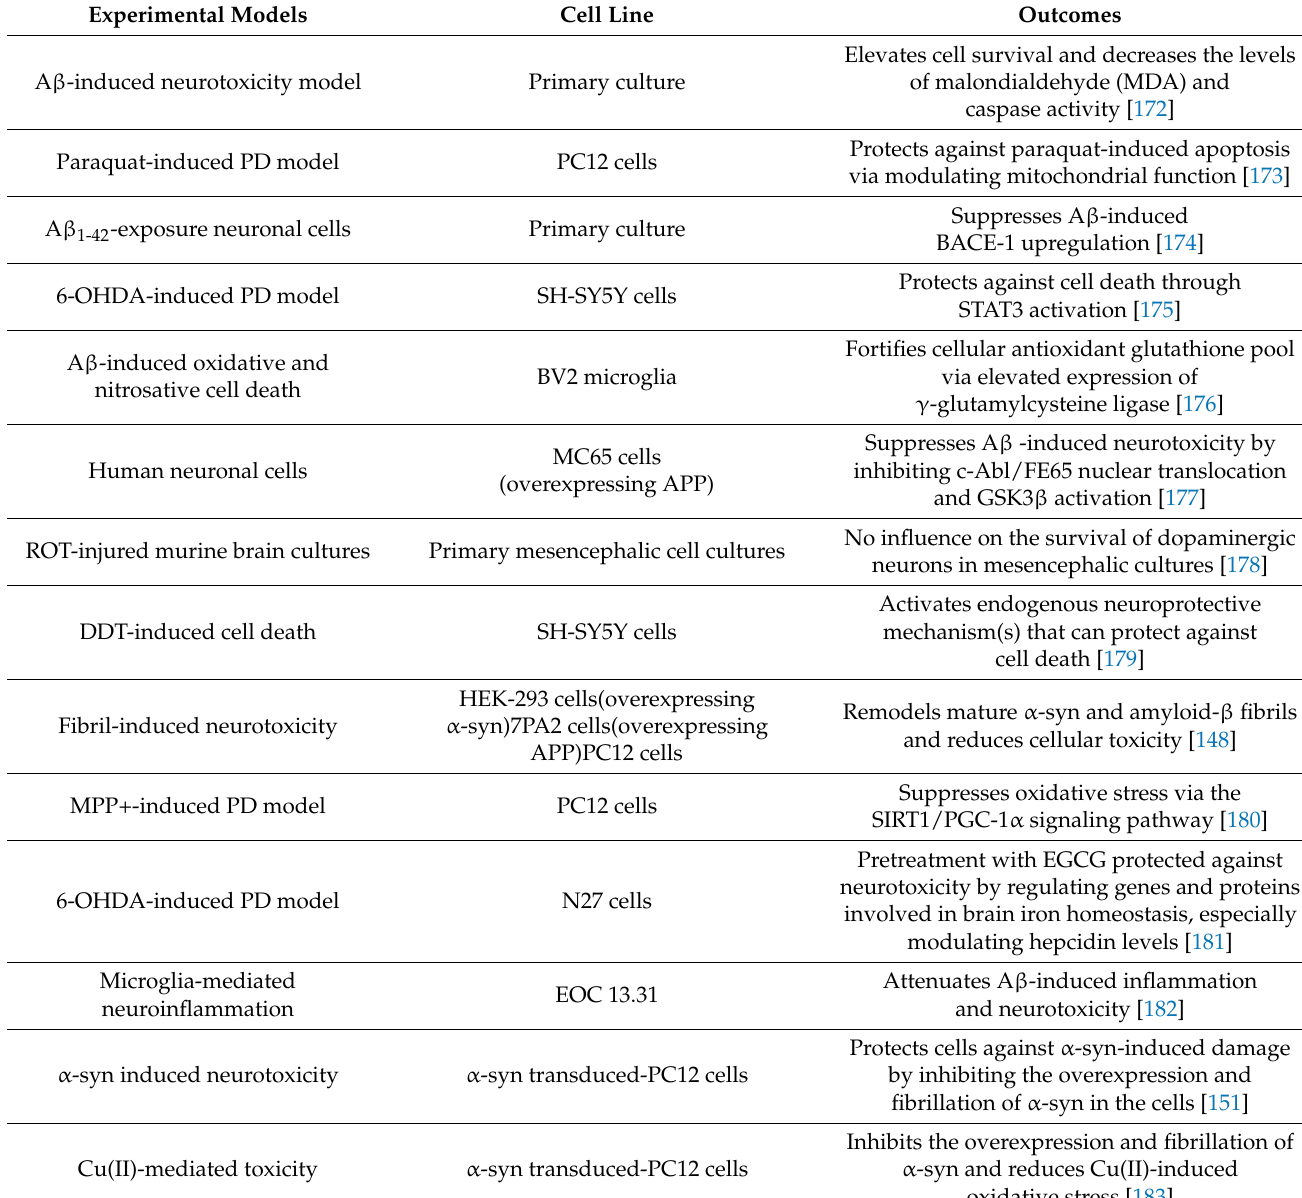
Table 2. Selected evidence of EGCG effectiveness on in vitro neurotoxicity